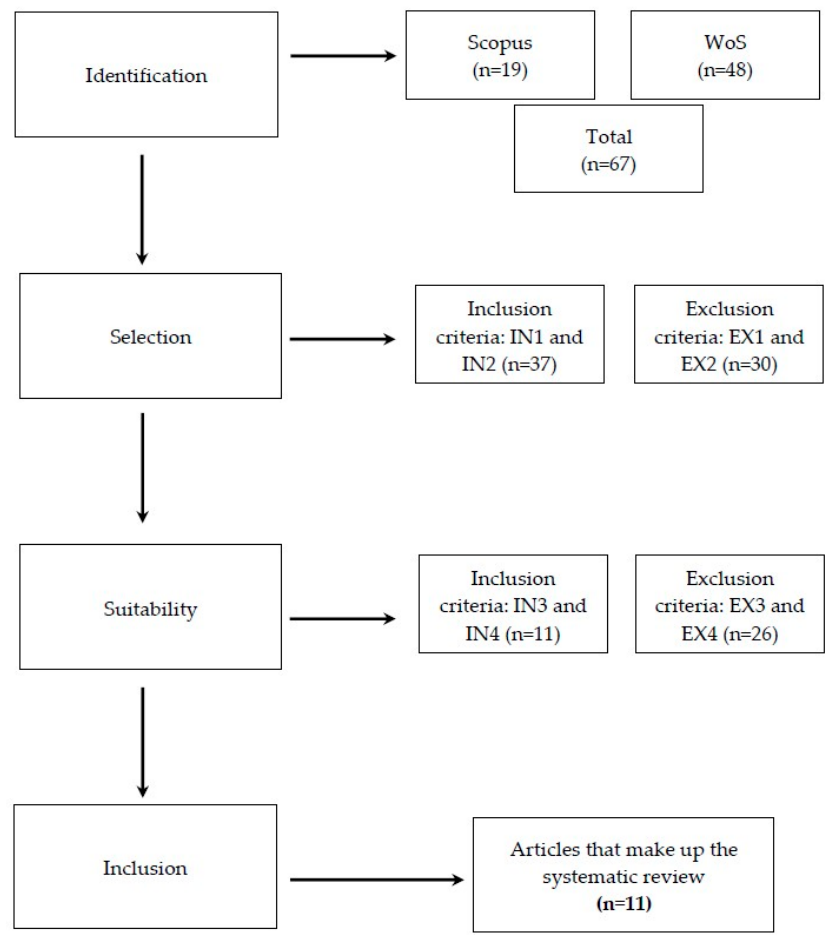
Figure 1. Flow chart. Source: own elaboration based on [12].